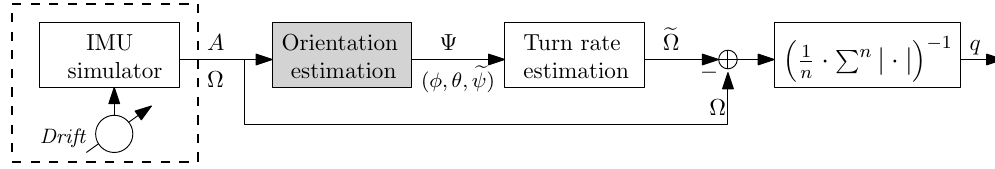
Figure 7. Simulation set up to verify the methodology to compute the quality factor. The drift generator can be configured as